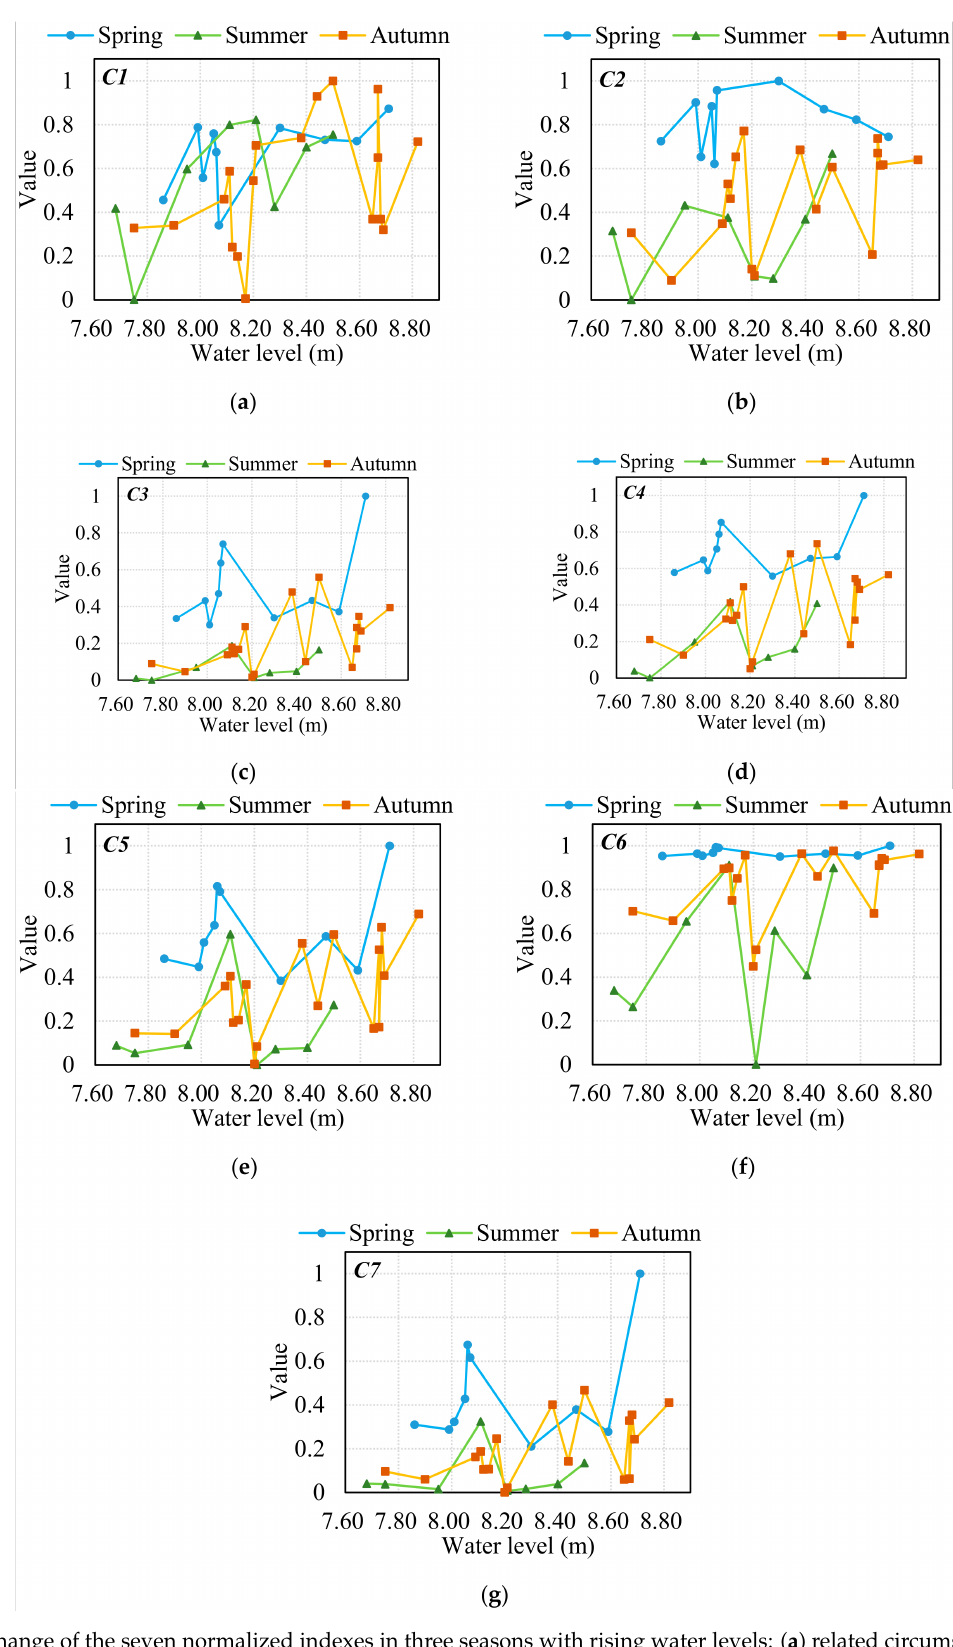
Figure 8. Change of the seven normalized indexes in three seasons with rising water levels: ( a ) related circumscribing circle index (C1); ( b ) Euclidean nearest neighbor distance index (C2); ( c ) probability of connectivity index(C3); ( d ) Shannon’s evenness index(C4); ( e ) aggregation index (C5); ( f ) splitting index(C6); ( g ) average area